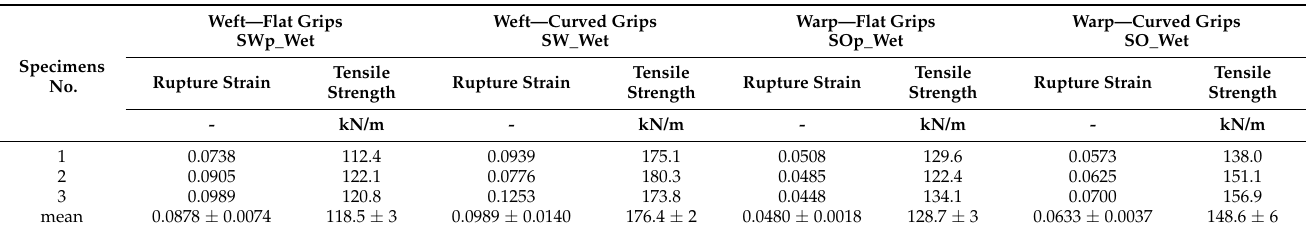
Table A2. Elongation at break and tensile strength—wet S type fabric.